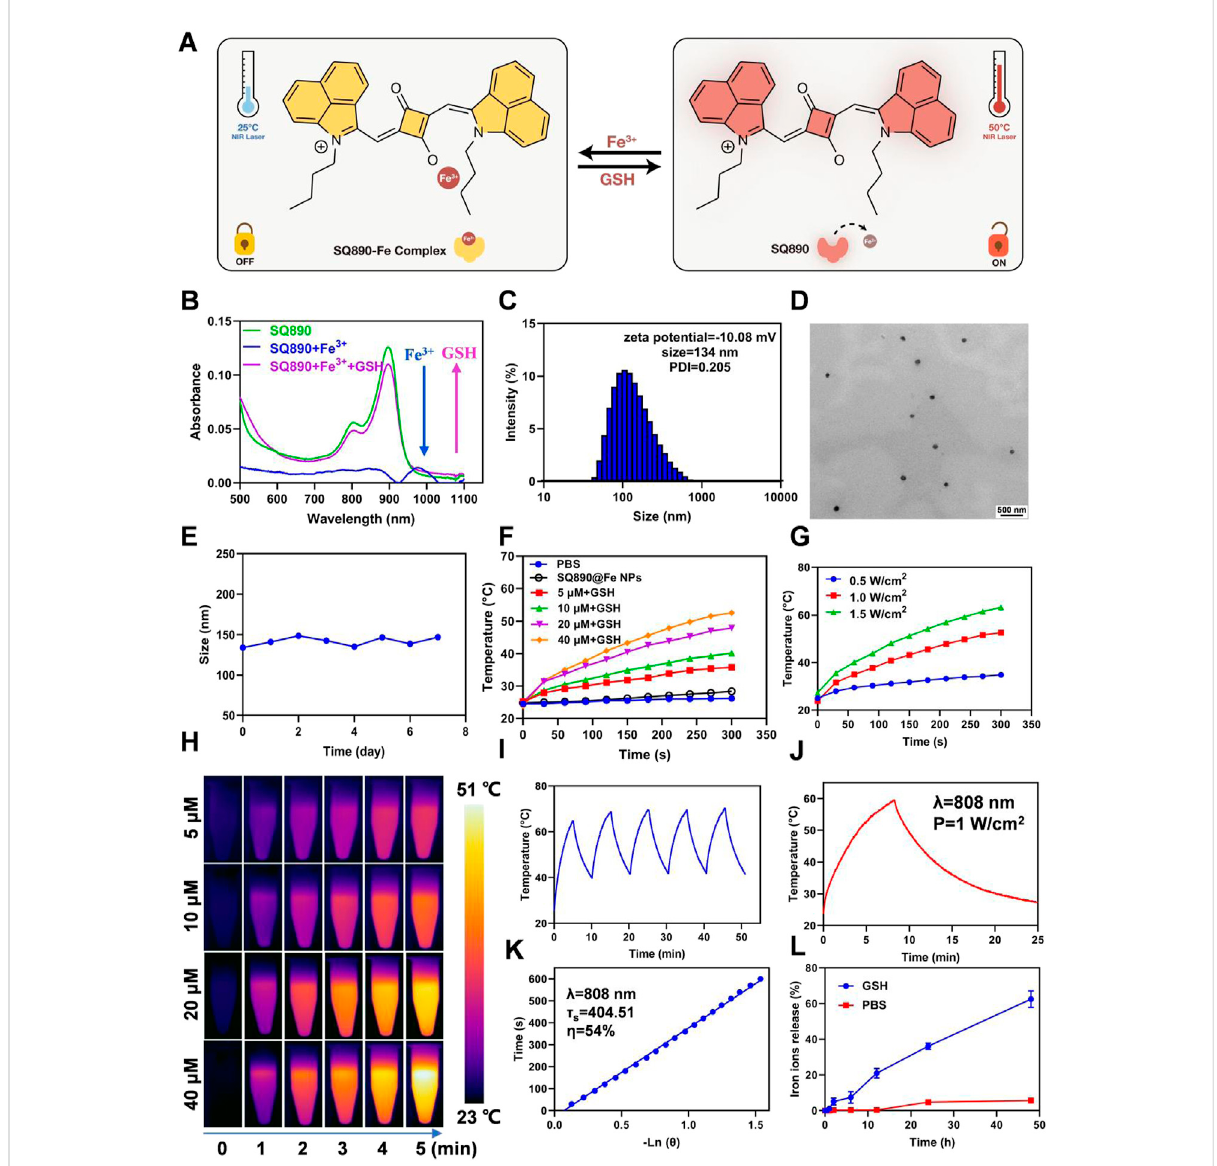
CharacterizationofSQ890@Fe NPs. (A) UndertheactionofGSH,thephotothermaleffectofSQ890-Fewasactivated, andFe 3+ wasreducedto Fe 2+ , which was released and lead to the occurrence of Fenton reaction and Ferroptosis. (B) The absorption spectra of SQ890 before and after treating with Fe 3+ ions, and Fe 3+ ions plus GSH. (C,D) Size distribution (C) and TEM images (D) of SQ890@Fe NPs. Scale bar: 500 nm. (E) Stability of SQ890@Fe NPs during 7 days. (F,G) Photothermal-heating curves (F) and infrared thermal images (H) of SQ890@Fe NPs at various concentrations with/without adding GSH (10 mM) under 808 nm laser illumination (1 W cm − 2 ) for 5 min. (H) The photothermal-heating curves of SQ890@Fe NPs (40 μ M) + GSH (10 mM) under different power laser irradiation. (I) Photothermic stability of SQ890@Fe NPs + GSH under 808